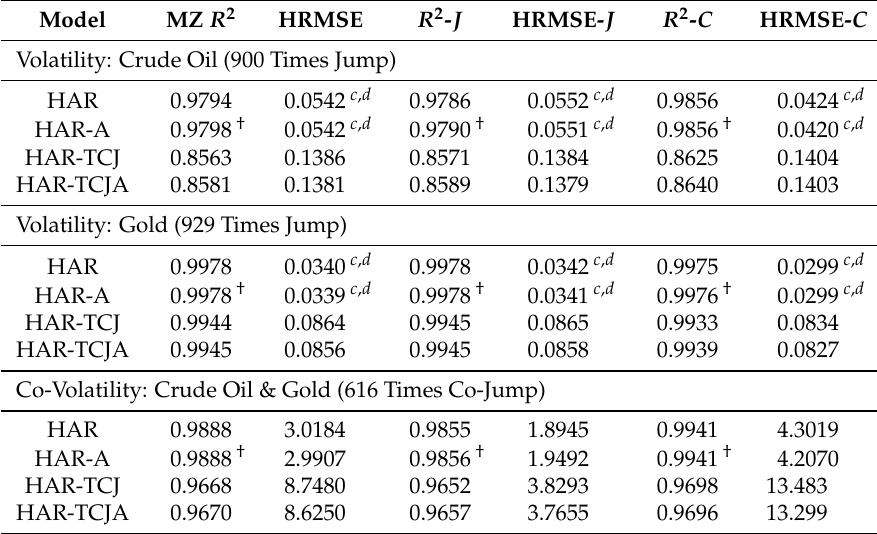
Table 8. Out-of-sample forecast evaluation for monthly regressions.